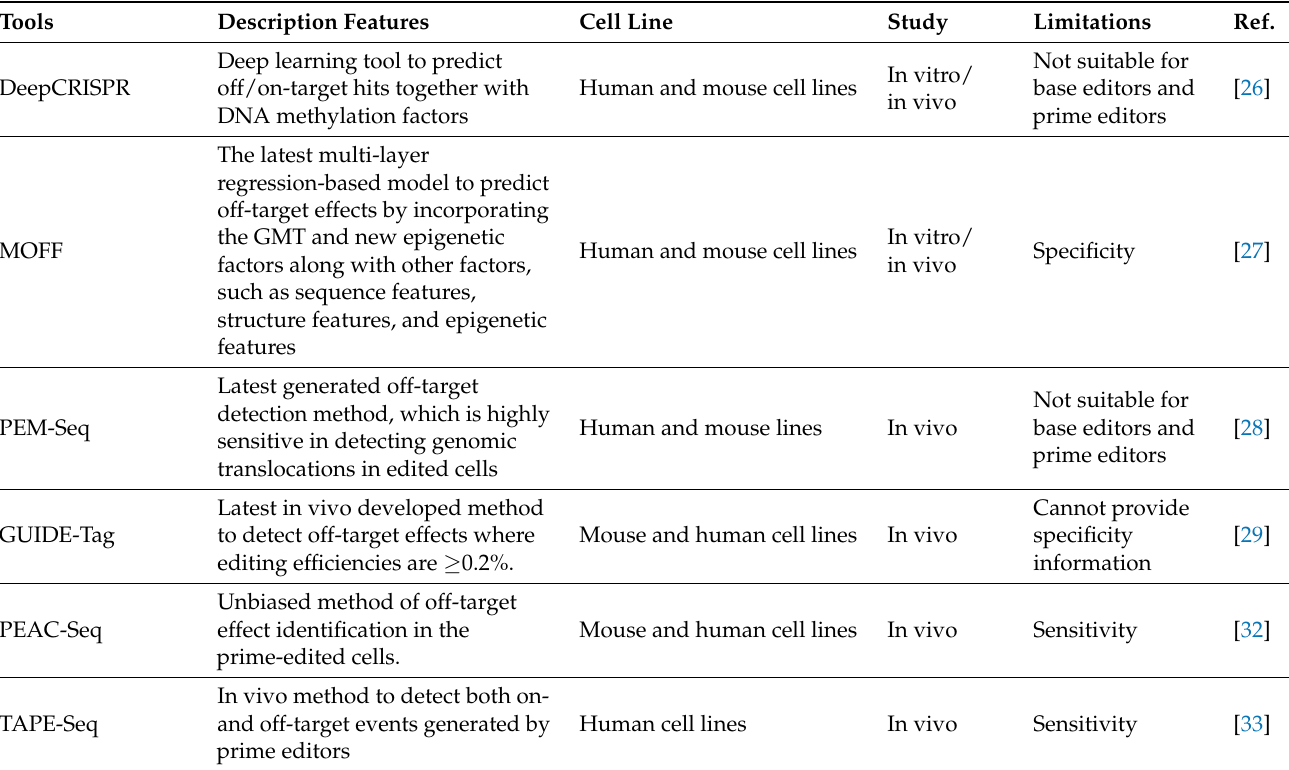
Table 1. Latest biased/unbiased off-target detection